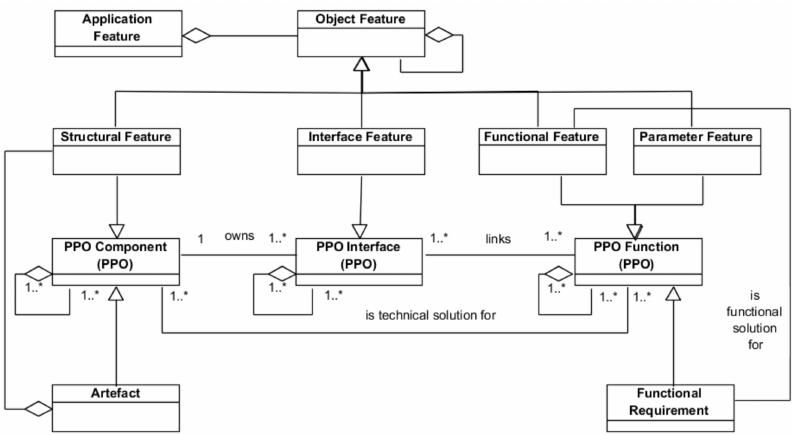
Figure 2. Updated basic structure of the Application Feature Model and its relation with the Product-Process-Organization (PPO)